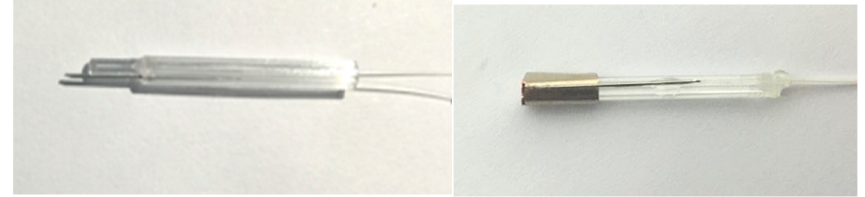
Figure 5. The real picture of sensor units.